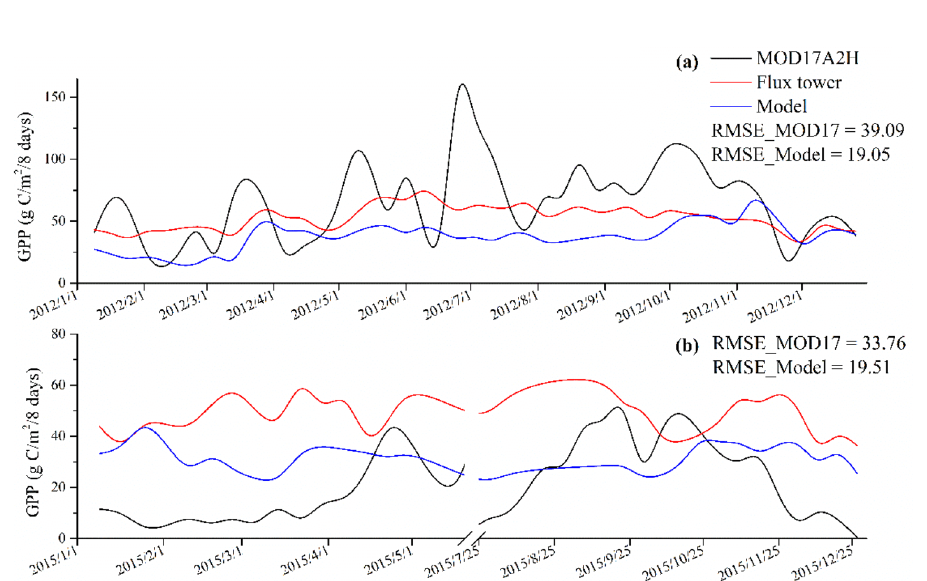
Figure 4. Validation of modeled GPP with flux-tower data from ( a ) Zhangjiang (2016–2017), ( b ) Zhangjiang (2012), and ( c ) Zhanjiang (2015).